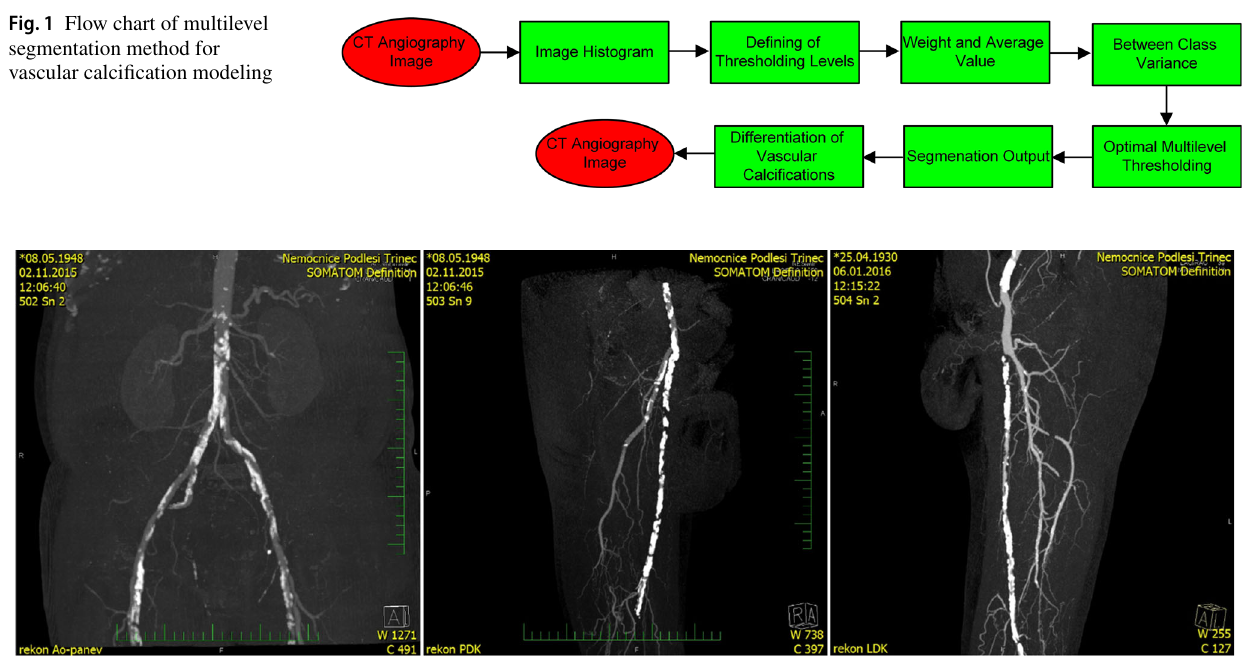
Fig. 2 Extract of analyzed images acquired by CT angiography to the range: [2 × j , 4 × j , 8 × j ], where j belongs to